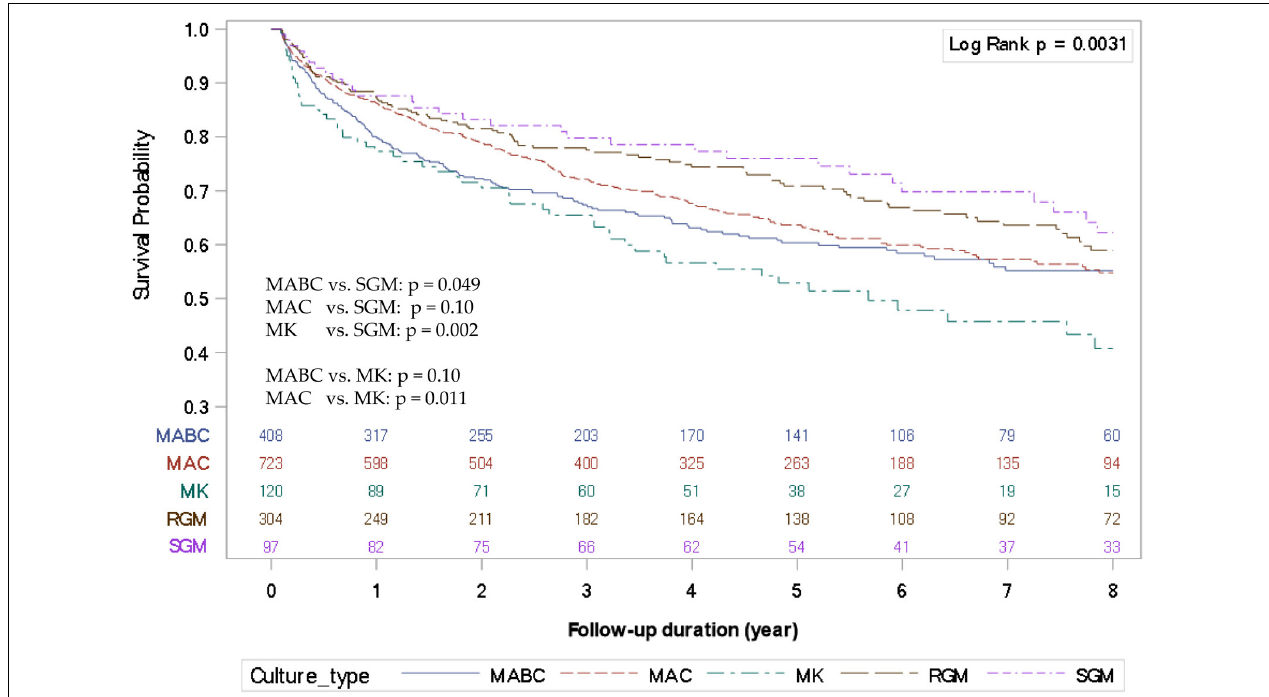
FIGURE 1 | Kaplan–Meier survival curves of nontuberculous mycobacterial lung disease (NTM-LD) according to different NTM species. MABC, Mycobacterium abscessus complex; MAC, Mycobacterium avium complex; MK, Mycobacterium kansasii ; SGM, slow-growing mycobacteria.